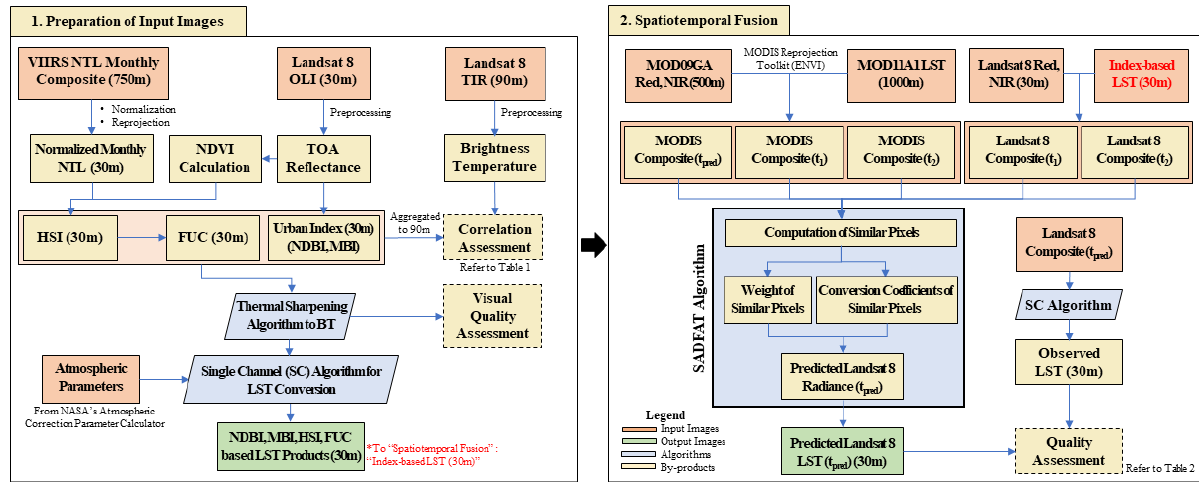
Figure 3. Overview of the two-phase methodology showing the input images and processes involved in this study Linear spectral mixture analysis was used since the majority of urban areas are filled with mixed pixels. Hence, each of the finer resolution Landsat pixels can be considered as a pure endmember within the resampled MODIS pixel. For this study, Landsat and MODIS images are assigned as the fine resolution and coarse resolution image inputs in the SADFAT algorithm,